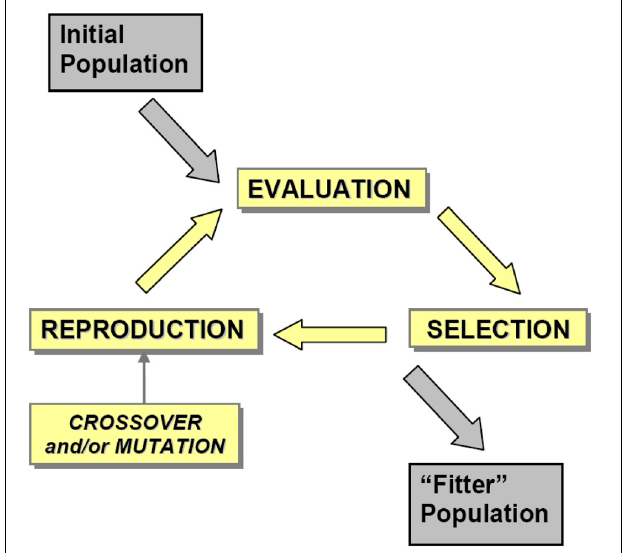
FIGURE 1 | The evolutionary cycle. An initial population, usually randomly generated, is evolved over several generations using an iterative process comprising EVALUATION, SELECTION and REPRODUCTION stages to produce a “fitter” population—the average fitness of the overall population has increased. EVALUATION is the means by which each individual in the population is attributed a fitness score, which is using gaze data in the GDEA. SELECTION is the means by which individuals are chosen to participate in the generation of “offspring” which will populate the next generation, and thus carry forward the genetic information contained in the chromosomes of both of the parents. REPRODUCTION is the means by which the genetic information from the “parents” is recombined to produce offspring, typically involving crossover (an exchange of genetic information from both parents, resulting in inheritance of properties from both parents) and mutation [random changes to the chromosome of the offspring resulting in novel properties not inherited from the